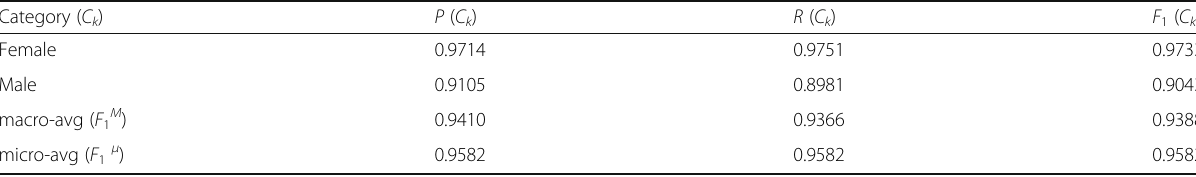
Table 4 Results with binary approach with cross validation = 5